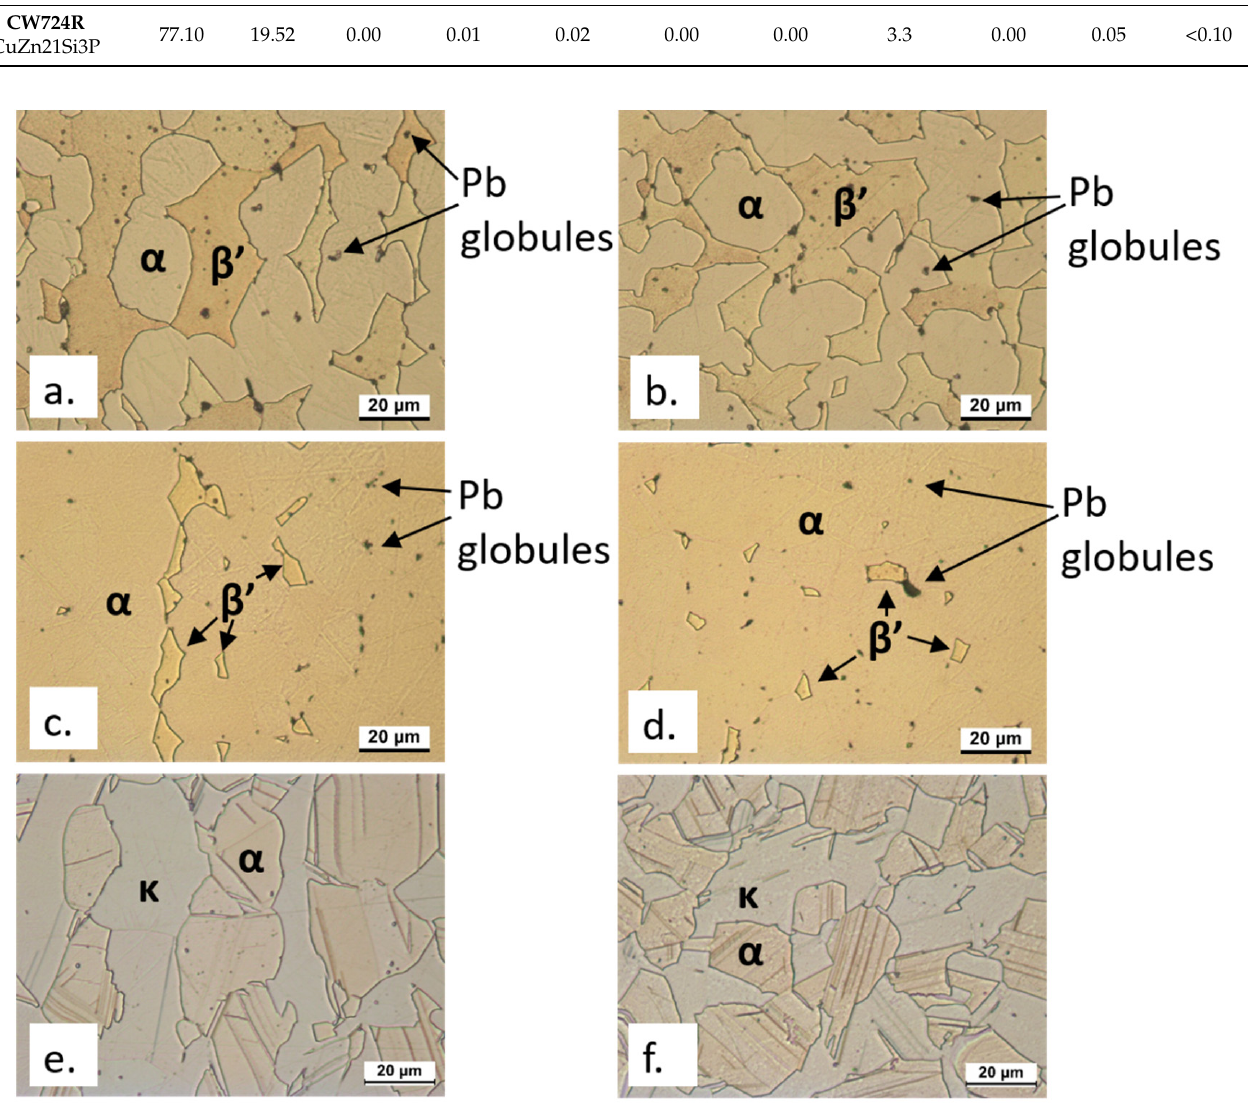
Figure 1. OM microstructures of etched longitudinal ( a , c , e ) and transverse ( b , d , f ) sections of CW617N (CuZn40Pb2: ( a , b )), CW602N (CuZn36Pb2As: ( c , d )), and CW724R (CuZn21Si3P: ( e , f )) samples. The longitudinal direction in ( a , c , e ) is the vertical one. The alloy CW617N and the dezincification-resistant CW602N evidenced α + β ’ mi- crostructures (that is mixed face-centered cubic, fcc, and body-centered cubic, bcc) with dispersed Pb globules, but the amounts of β ’ were quite different, that is 62 ± 3% in the former and 10 ± 2% in the latter alloy (as calculated by image analysis software). CW724R exhibited about 40 ± 2% κ phase (grey in color in Figure 1) and balance α phase (pale pink in Figure 1). κ is a hard Si-rich phase, with close-packed hexagonal (cph) lattice and atomic composition close to the stoichiometry Cu8Zn2Si [8]. In CW724R,